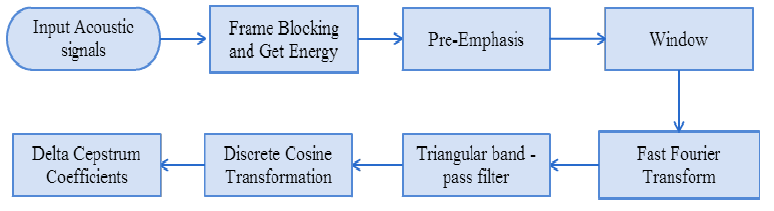
Figure 12. Relationship between human perception and actual frequency.